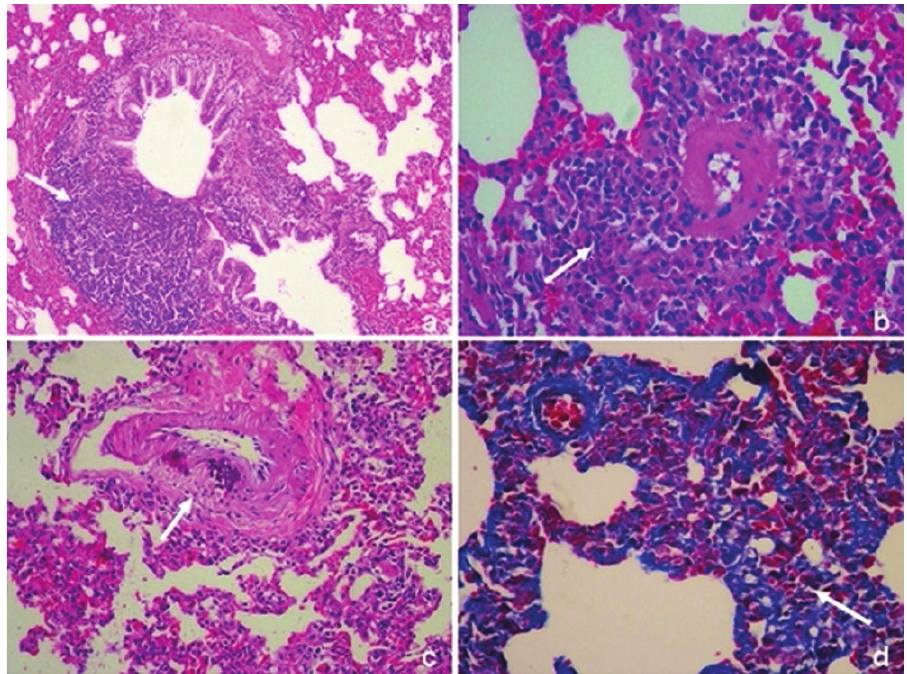
Figure 3 - Histopathological findings in the cigarette smoke-exposed group (Group II). (a) peribronchial inflammation (arrow) (H&E, 6 20). (b) perivascular inflammation and vascular wall thickness (arrow) (H&E, 6 20). (c) vascular wall thickness and calcification (arrow) (H&E, 6 20). (d) parenchymal infiltration and fibrosis (arrow) (Masson’s trichrome, 6 20).